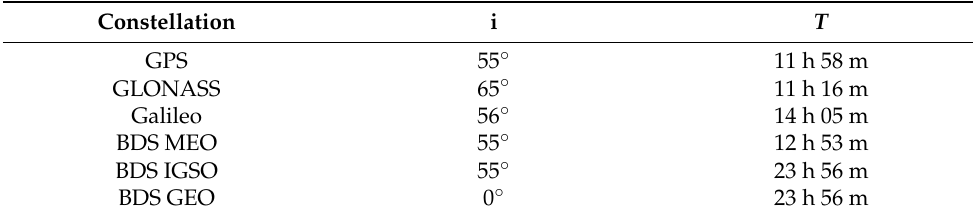
Table 2. General characteristic of GNSS orbits modes (i: inclination, T : orbital period). Constellation